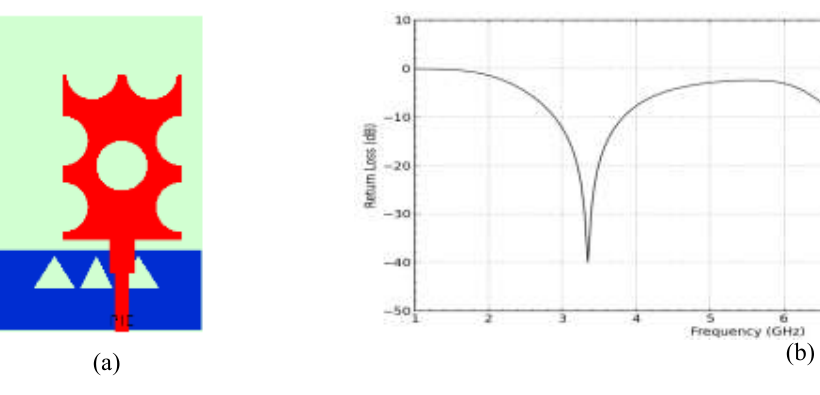
Figure 9: (a) Proposed antenna design and (b) its return loss (simulated)